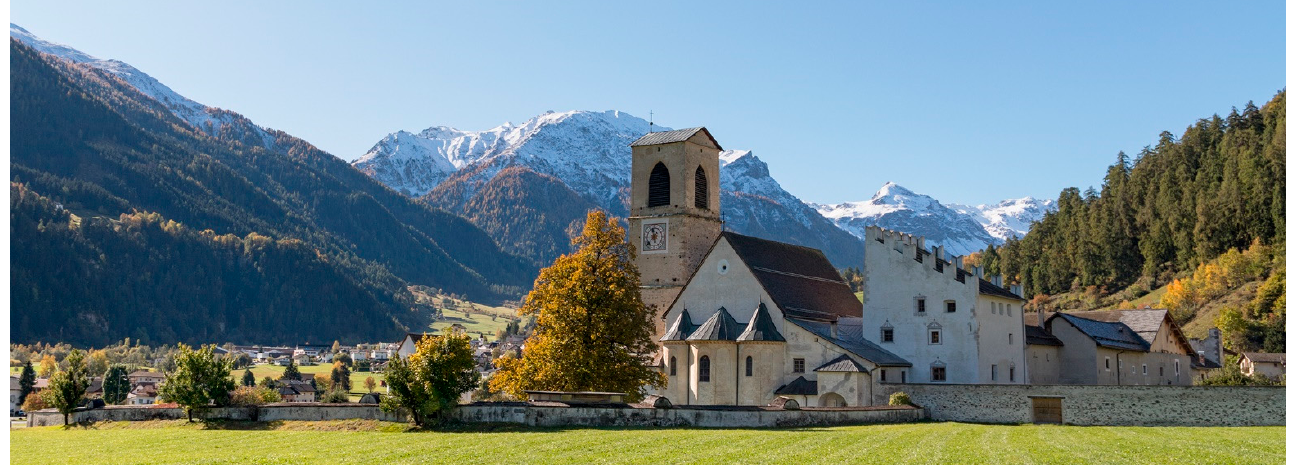
Figure 1. Panoramic picture of the Convent of Saint John in Müstair from the east to the west (photograph by K. Löcker, adapted by G. Verhoeven).